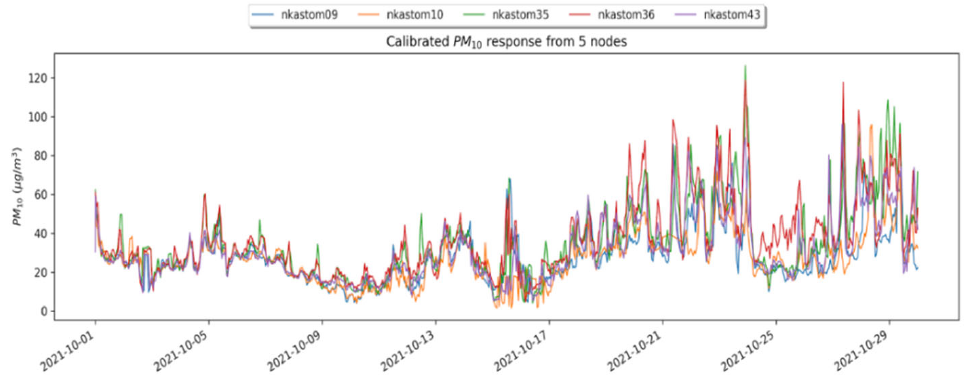
Figure 14. Calibrated response from 5 PM 10 LCS not involved in the training. nkastom## refers to the code id of the node.